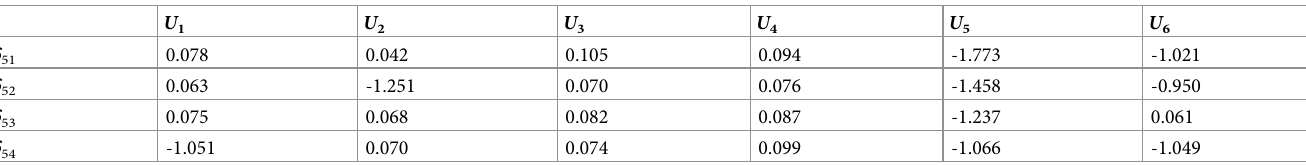
Table 28. The dominance of O 5 to others.